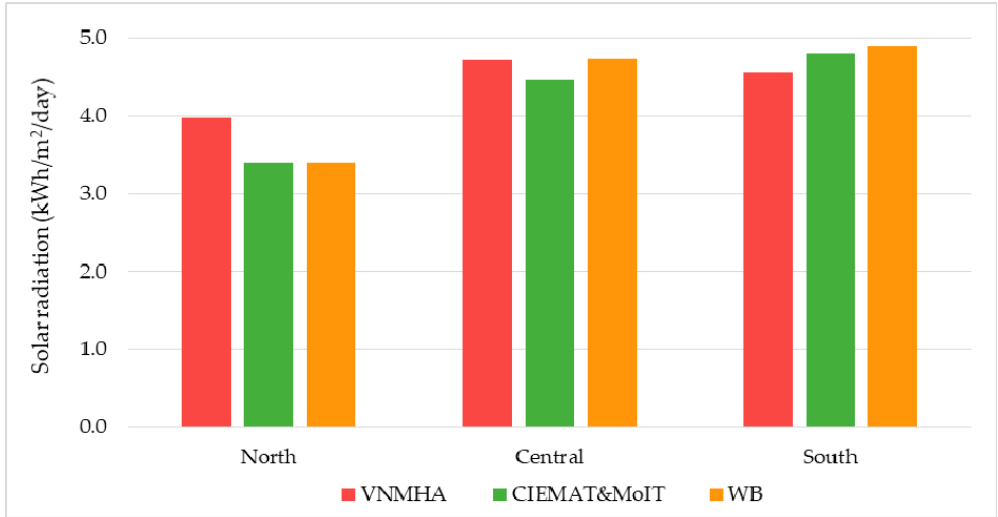
Figure 7. Comparison of solar potential assessment between VNMHA (2005), CIEMAT&MoIT (2015), and WB (2019).